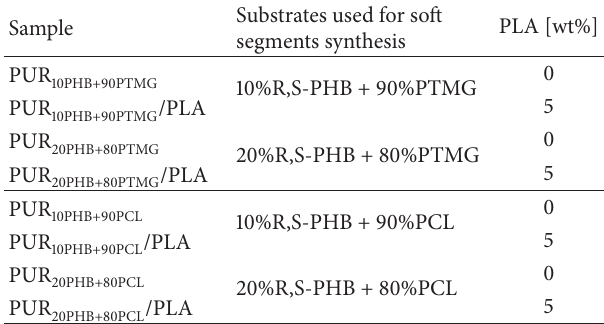
Table 1: Composition of polyurethanes and their blends. Sample